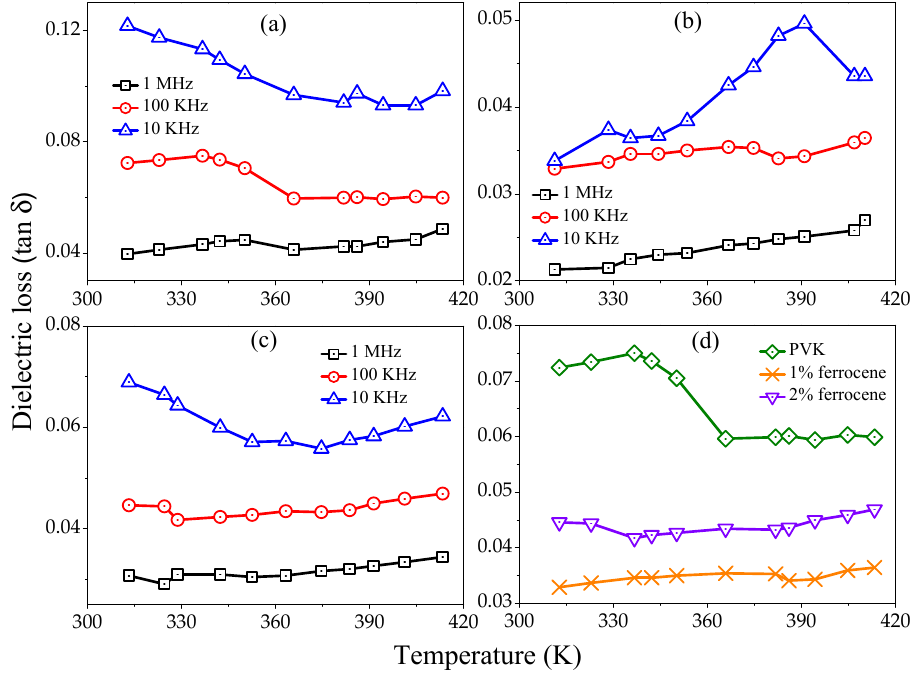
Figure 5. Variation of real part of loss tangent (tan δ ) as function of temperature for ( a ) pure PVK, ( b ) 1% ferrocene doped PVK, ( c ) 2% ferrocene doped PVK, and ( d ) at frequency of 100 kHz for pure and doped PVKs.